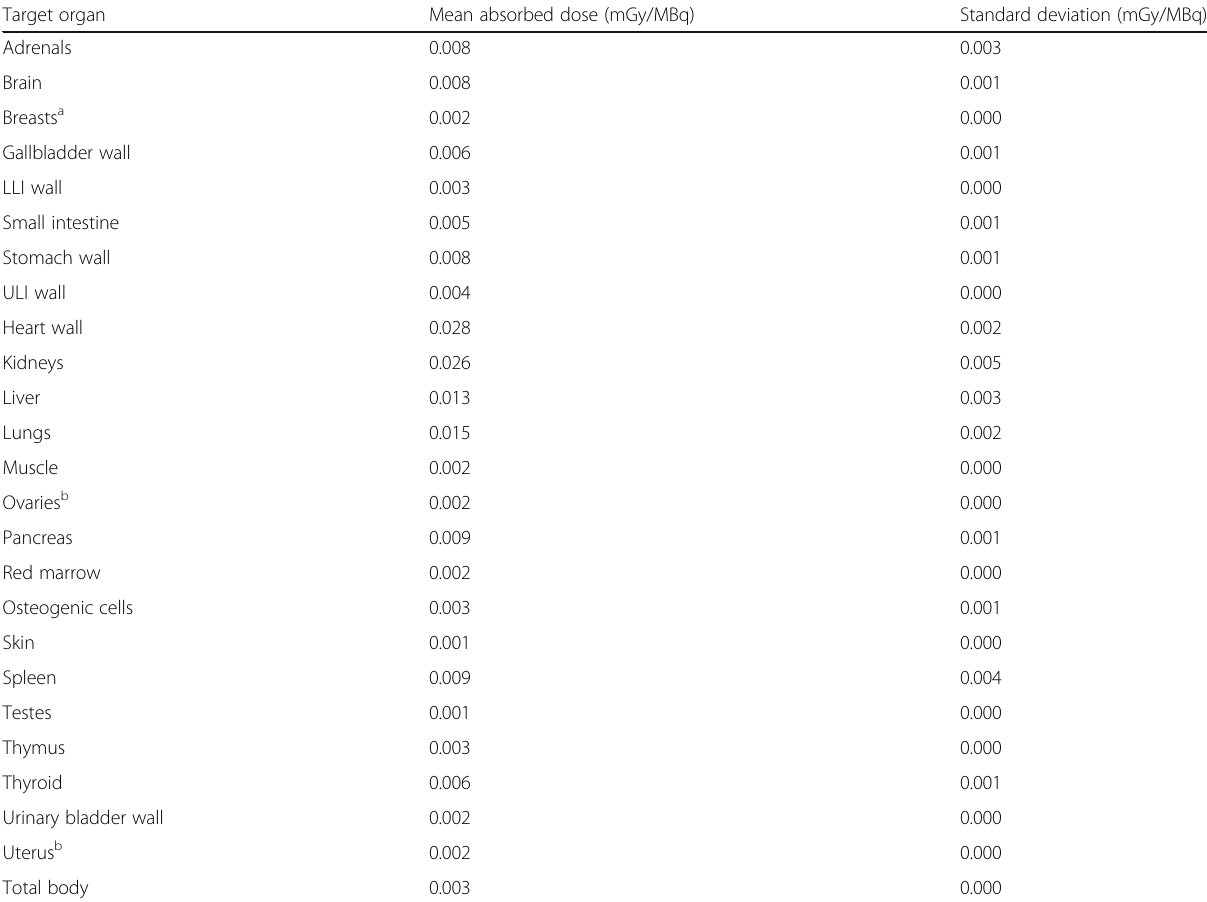
Table 3 Effective doses in measured target organs Target